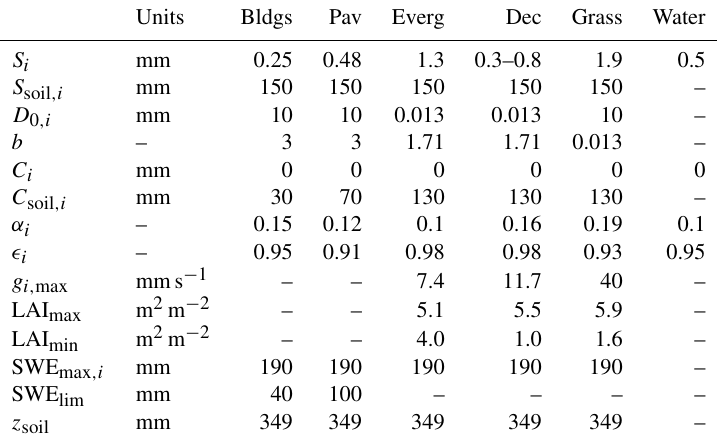
Table A2. Model parameters used in SUEWS for different surfaces: buildings (Bldgs), paved (Pav), evergreen vegetation (Everg), deciduous vegetation (Dec), grass, and water. Initial conditions assume there is no snow on the ground, and the leaf area index of each vegetation type is at its minimum value. See Table A1 for notation and Järvi et al. (2011, 2014) for data sources.